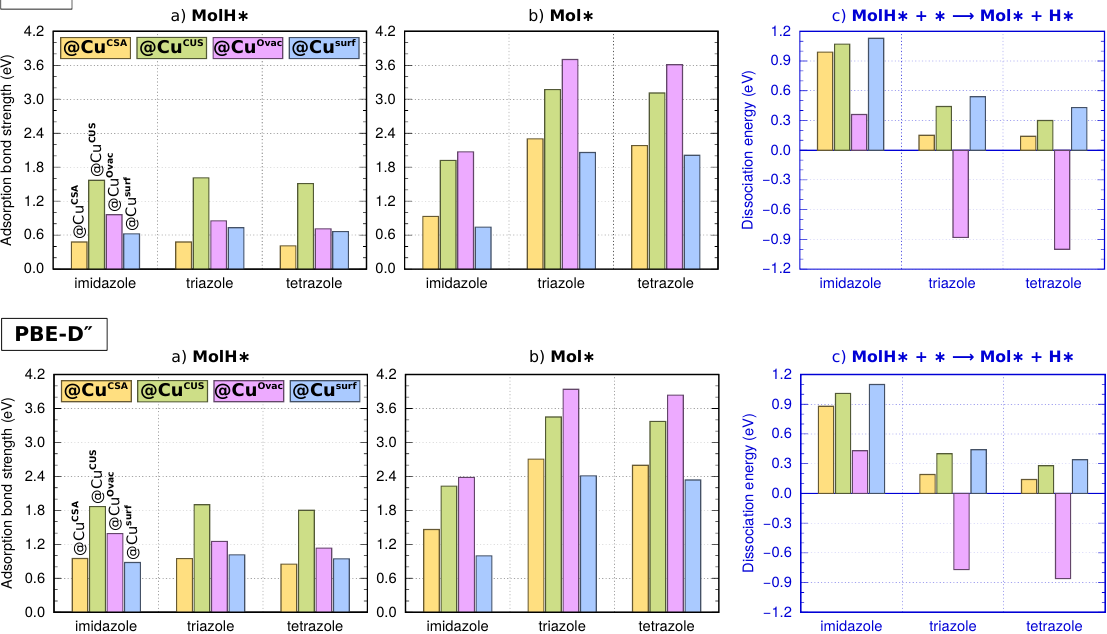
Figure 3. PBE ( top ) and PBE-D (cid:48)(cid:48) ( bottom ) calculated bond-strengths for ( a ) MolH ∗ and ( b ) Mol ∗ adsorption modes of imidazole, triazole, and tetrazole at considered Cu sites and the respective ( c ) dissociation energies for MolH ∗ + ∗ → Mol ∗ + H ∗ reaction (N1–H bond cleavage); note that after the dissociation the H binds to a nearby lattice O ion thus forming a surface OH group. The association between sites and surfaces is as follows: Cu CSA corresponds to Cu 2 O(111)-w/o-Cu CUS , Cu CUS to √ √ Cu 2 O(111) w/o +1Cu CUS , Cu Ovac to Cu 2 O(111)-recon-( 3 × 3) R 30 ◦ , and Cu surf to Cu 2